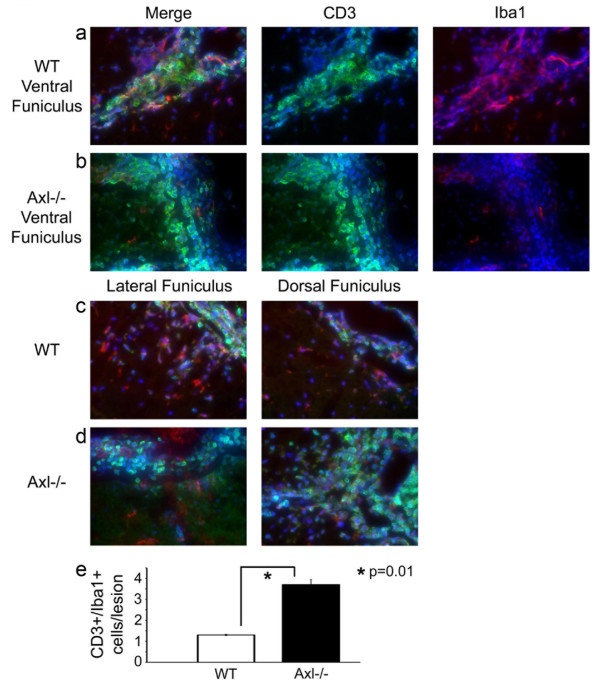
Double-label immunofluorescence confirm Axl-/- (b,d) mice have fewer Iba1+ microglia/macrophages than WT (a,c) mice in ventral (a,b), lateral and dorsal funiculi (c,d). Ten micron frozen spinal cord sections were stained with an Iba1 pAb (red), a CD3 mAb (green), counterstained with Hoechst stain (blue), and visualized by immunofluorescence. a,b) Left panel shows merged triple fluorescence, middle panel shows CD3/Hoechst, and right panel shows Iba1/Hoechst for the ventral funiculus of WT (a) and Axl-/- (b) spinal cords. c,d) Merged images of lateral and dorsal funiculi for WT and Axl-/- spinal cords. All images are 40×. e) CD3+/Iba1+ cells/lesion for WT and Axl-/- mice.